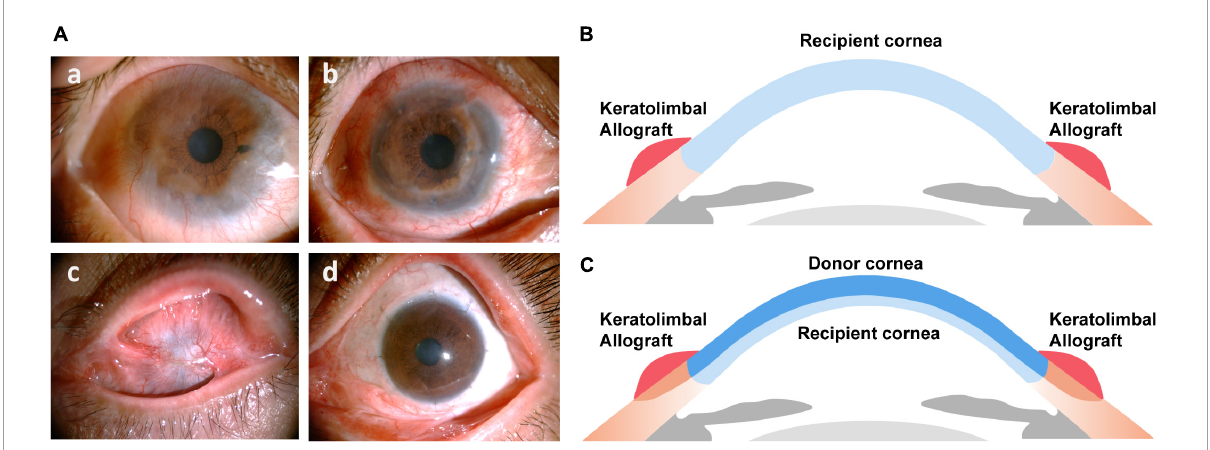
FIGURE1 (A) Postoperative outcomes of KLAL transplantation in patients with severe bilateral limbal stem cell deficiency caused by chemical burns. Clinical photographs of the right eye of a 57-year-old male before KLAL-only transplantation (a), 12 months after KLAL-only transplantation (b) and the left eye of a 40-year-old female before KLAL transplantation combined with DALK (KLAL-DALK) (c), 12 months after KLAL-DALK (d). (B,C) The positioning of the graft in relation to angle structures. Keratolimbal allograft transplantation (B) . Keratolimbal allograft transplantation combined with deep anterior lamellar keratoplasty (C) . KLAL, keratolimbal allograft; DALK, deep anterior lamellar